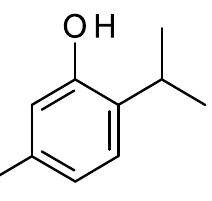
Figure 4. Structure of 2-isopropyl-5-methylphenol.